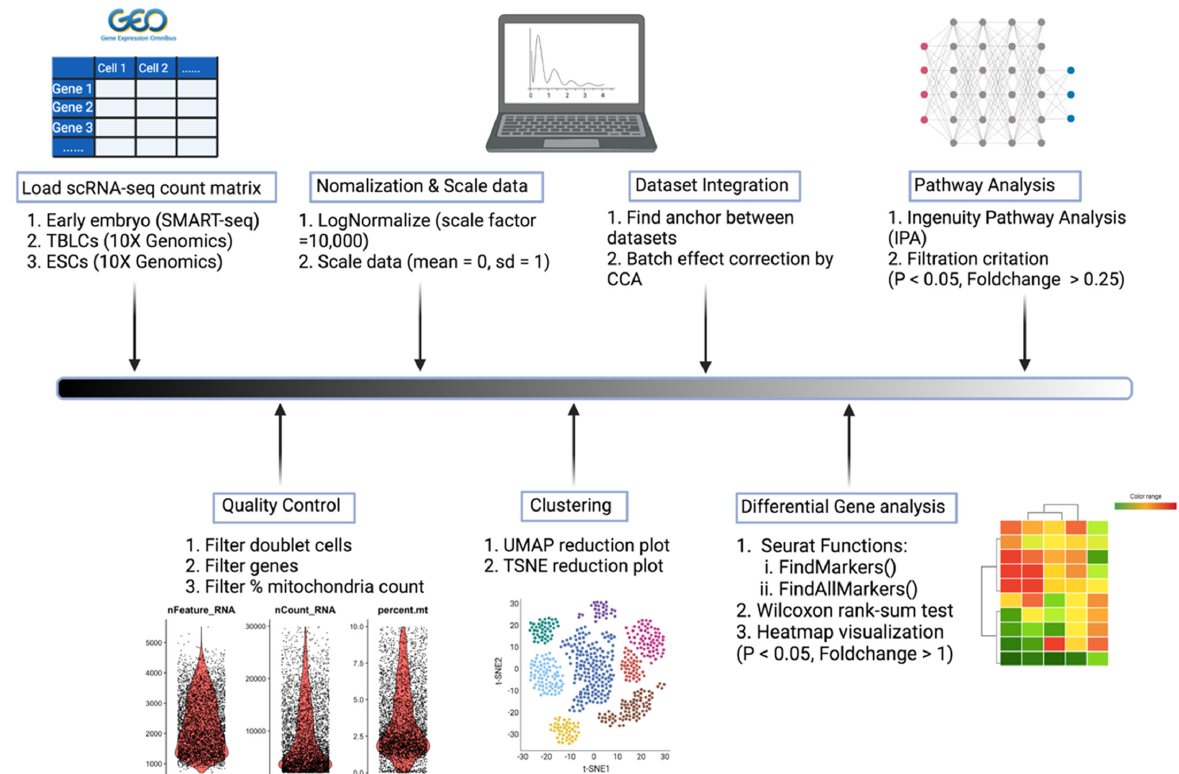
Figure 2. Workflow of single-cell RNA sequencing data analyses.